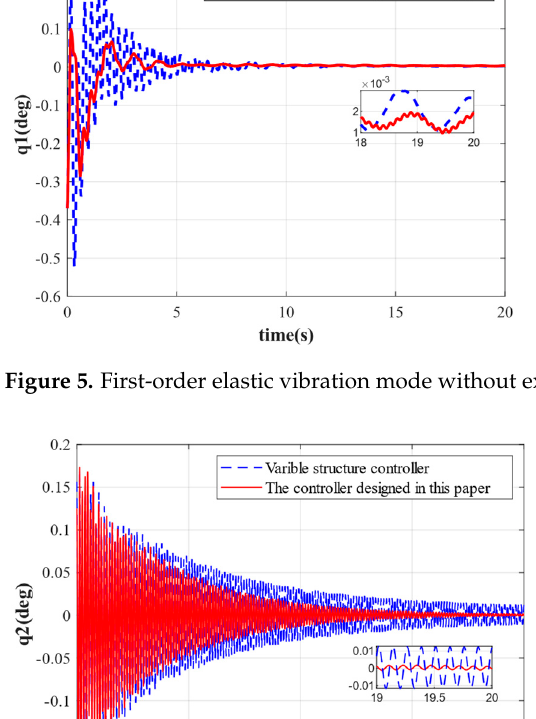
Figure 4. Attitude angular rate reconstruction without external interference.